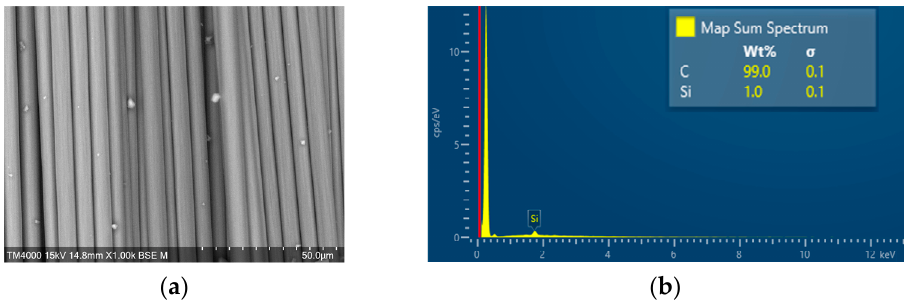
Figure 8. SEM ‐ EDS observation of OCF. ( a ) SEM (1000×); ( b ) EDS.